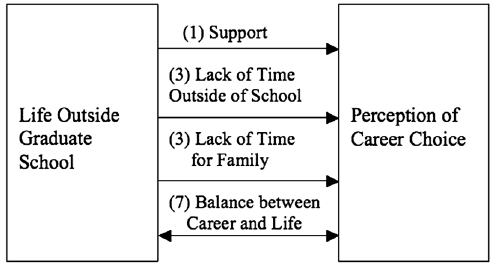
FIG. 2. 1B. How do their lives outside of school impact their perception of their career choice?